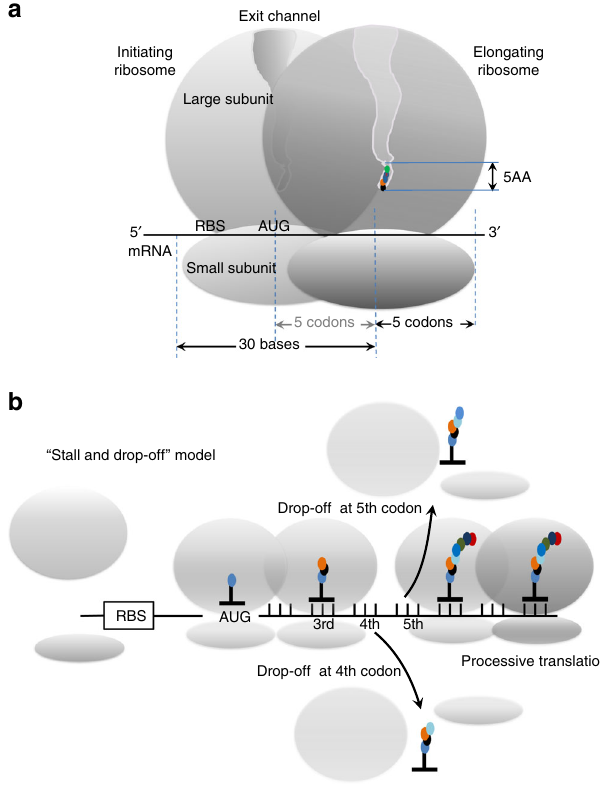
Fig. 9 Model for translational regulation by the identity of N-terminal sequence. a Schematic representing the initiating and elongating ribosome footprints as well as a movement during the translation of the fi rst fi ve codons described in this manuscript. b “ Stall and drop-off ” model in translational regulation by the identity of N-terminal sequence. Arrows indicate stalled and abortive translation on non-processive peptides followed by ribosome recycling and peptidyl-tRNA drop-off at codons 4 and 5. Start codon (AUG), ribosome binding site (RBS), ribosomal subunits, peptide exit channel, ribosome footprint, peptidyl-tRNAs, amino acids as well as position of detrimental 3 – 5 codons is